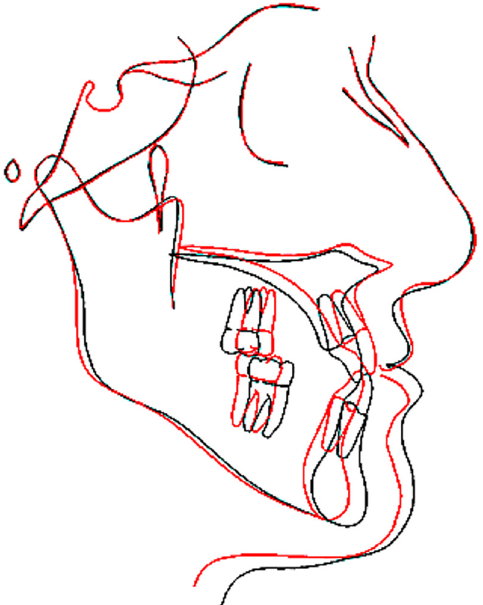
Figure 12. Cephalometric superimposition on sella: Pretreatment (black line) and posttreatment (red